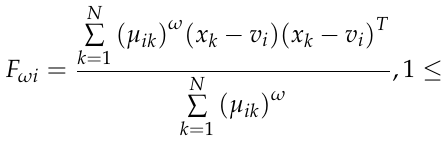
Figure 12. Visualization of the classification results of the driver’s steering intention based on the Gustafson–Kessel algorithm.